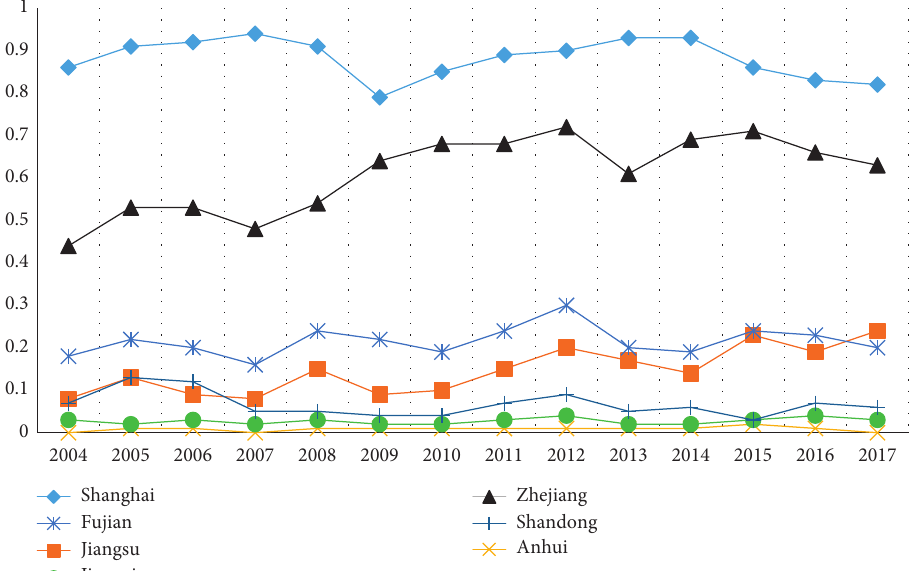
Figure 3: GFI in northeast China from 2004–2017.